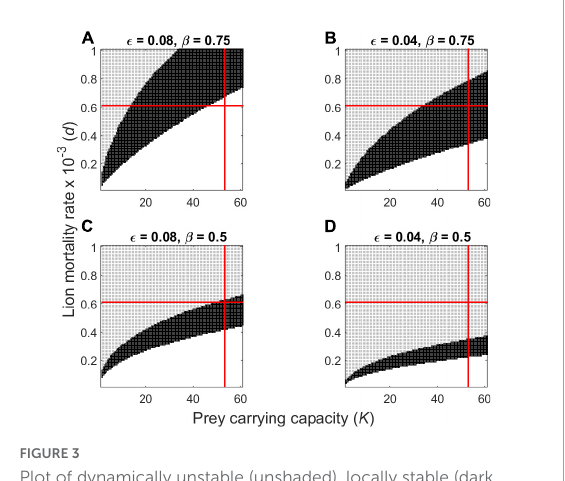
FIGURE3 Plot of dynamically unstable (unshaded), locally stable (dark shading), and unsustainable (moderate shading) outcomes for the group-dependent predator-prey model applied to lions feeding exclusively on wildebeest (Eqs 3, 4) as determined by predator mortality rate ( d ) and prey carrying capacity ( K ). Parameter values in panel (D) represent the observed grouping parameters for Serengeti wildebeest ( ε = 0.04 and β = 0.50). The other panels demonstrate the impact of modifying prey grouping parameters (A) reducing both mean group size and grouping tendency ( ε = 0.08 and β = 0.75); (B) retaining mean group size, reducing grouping tendency ( ε = 0.04 and β = 0.75); (C) reducing mean group size, retaining grouping tendency ( ε = 0.08 and β = 0.50). The red lines depict the estimated values of lion d and wildebeest K for Serengeti.